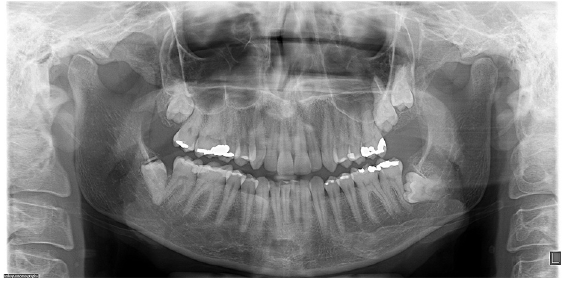
Figure 1. Representative image of a digital panoramic radiograph used in this